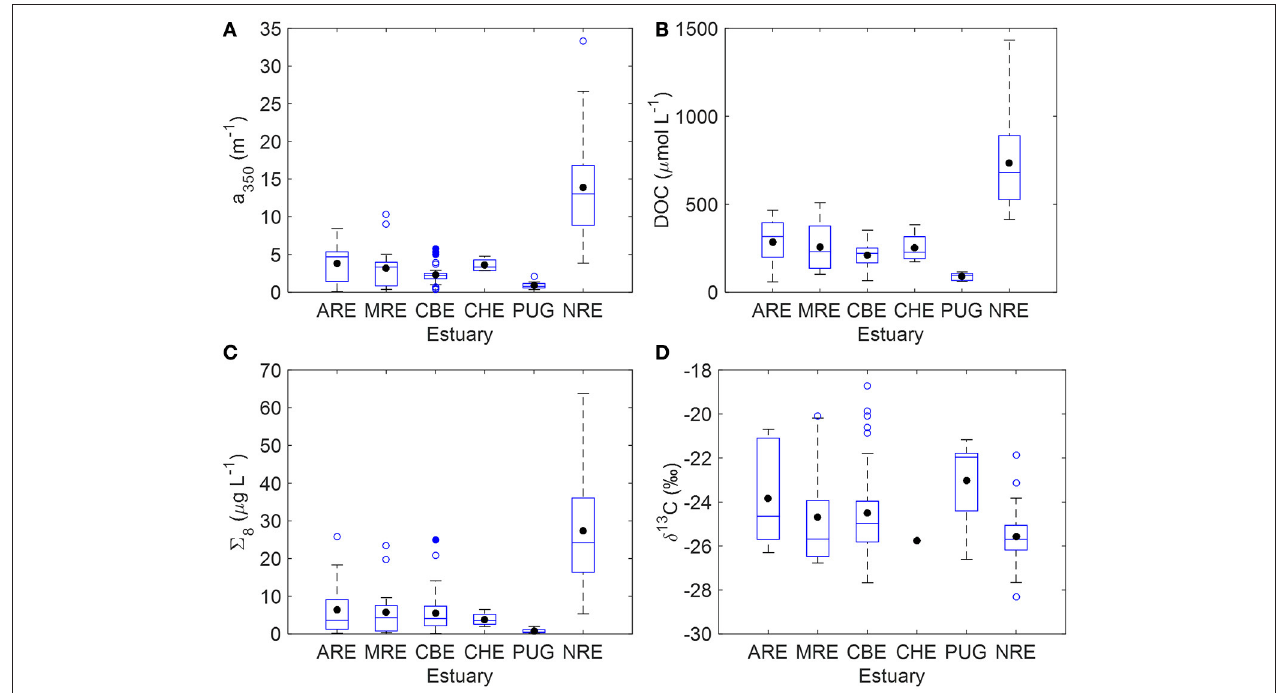
FIGURE 2 | Boxplots summarizing key variables measured for the six estuaries in this study. (A) CDOM absorption at 350nm (a 350 ); (B) DOC concentration; (C) sum of 8 lignin phenols ( 6 8 ); (D) stable carbon isotope values of DOC ( δ 13 C-DOC). The blue solid line is the median and the black circle is the mean; the edges of the boxes denote the 25th and 75th percentiles, while the whiskers denote the 10th and 90th percentiles, and blue circles represent outliers.